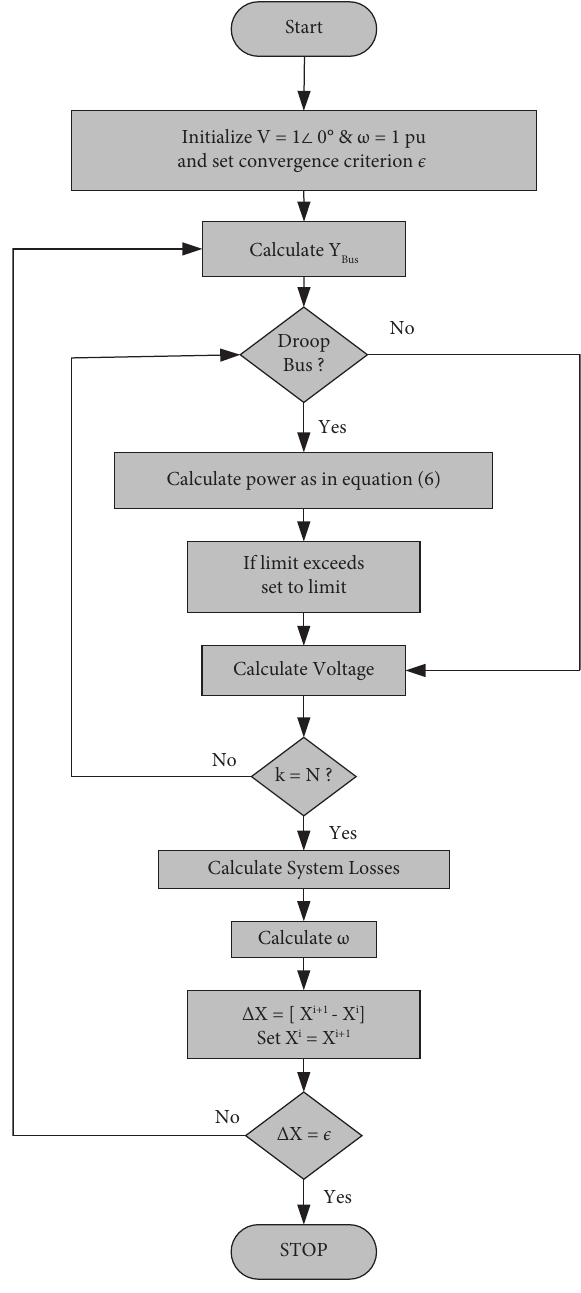
Figure 1: Flowchart of microgrid load